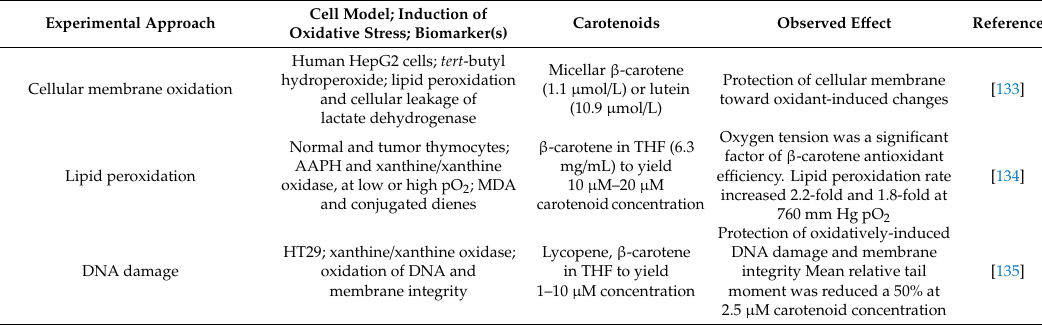
Table 5. Relevant studies dealing with the antioxidant capacity of carotenoids in cell systems. Experimental